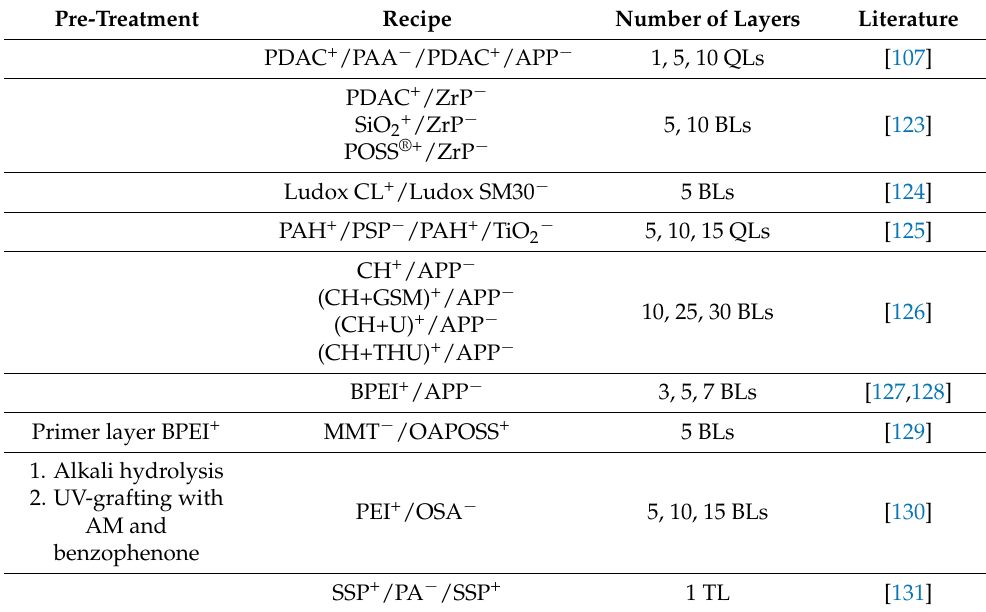
Table 3. Cationic/anionic compounds used to achieve FR of polyester